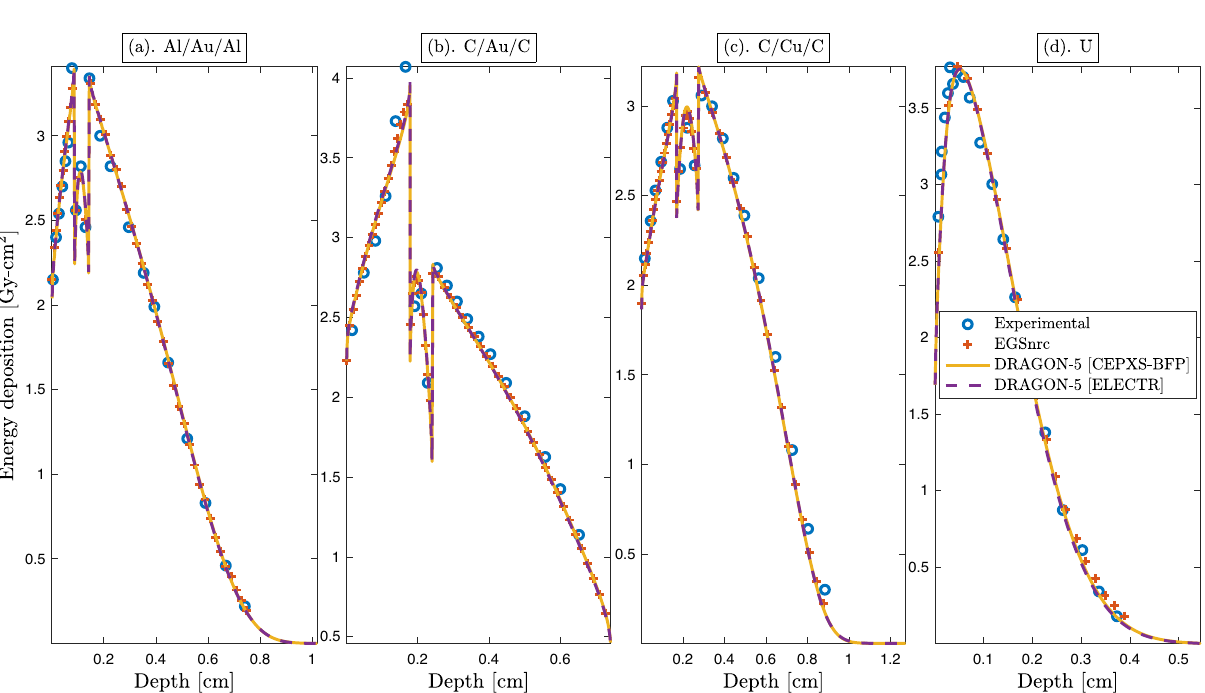
Figure 8. ( a ) Njoy-Dragon-5 mean relative errors in energy deposition profiles with respect to Geant-4 as a function of the incident beam’s energy. Curves are limited to Class-I and -II atoms. ( b ) Homogeneous atomic slabs’ voxels percentage satisfying a 2% BFP-MC relative dose difference vs. Z . Monte Carlo convergences are obtained for a 0.2% mean standard deviation.